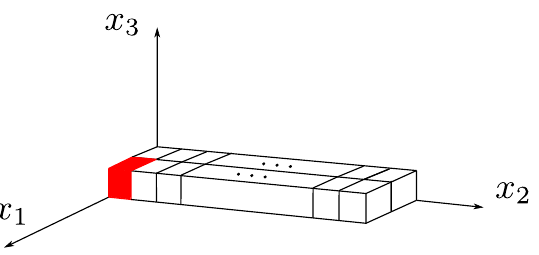
Figure 9 . Illustration of a bud in the case of twin plane partitions for the N = 2 a(cid:14)ne Yangian of [23]. In order to create the second row by acting with x on the state corresponding to the (cid:12)rst row, one has to (cid:12)rst create a single box (the bud of length one) depicted in red. This also applies to the case of p = 0 later, see eq. (3.31) and (cid:12)gure 10. algebra (this is true both from the analysis of fermionic characters and of bosonic